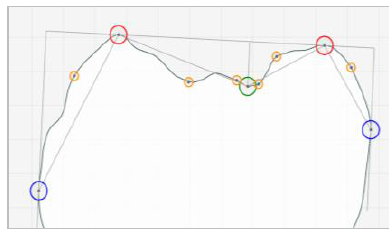
Figure 5. Burial Nr 3 of Nerqin